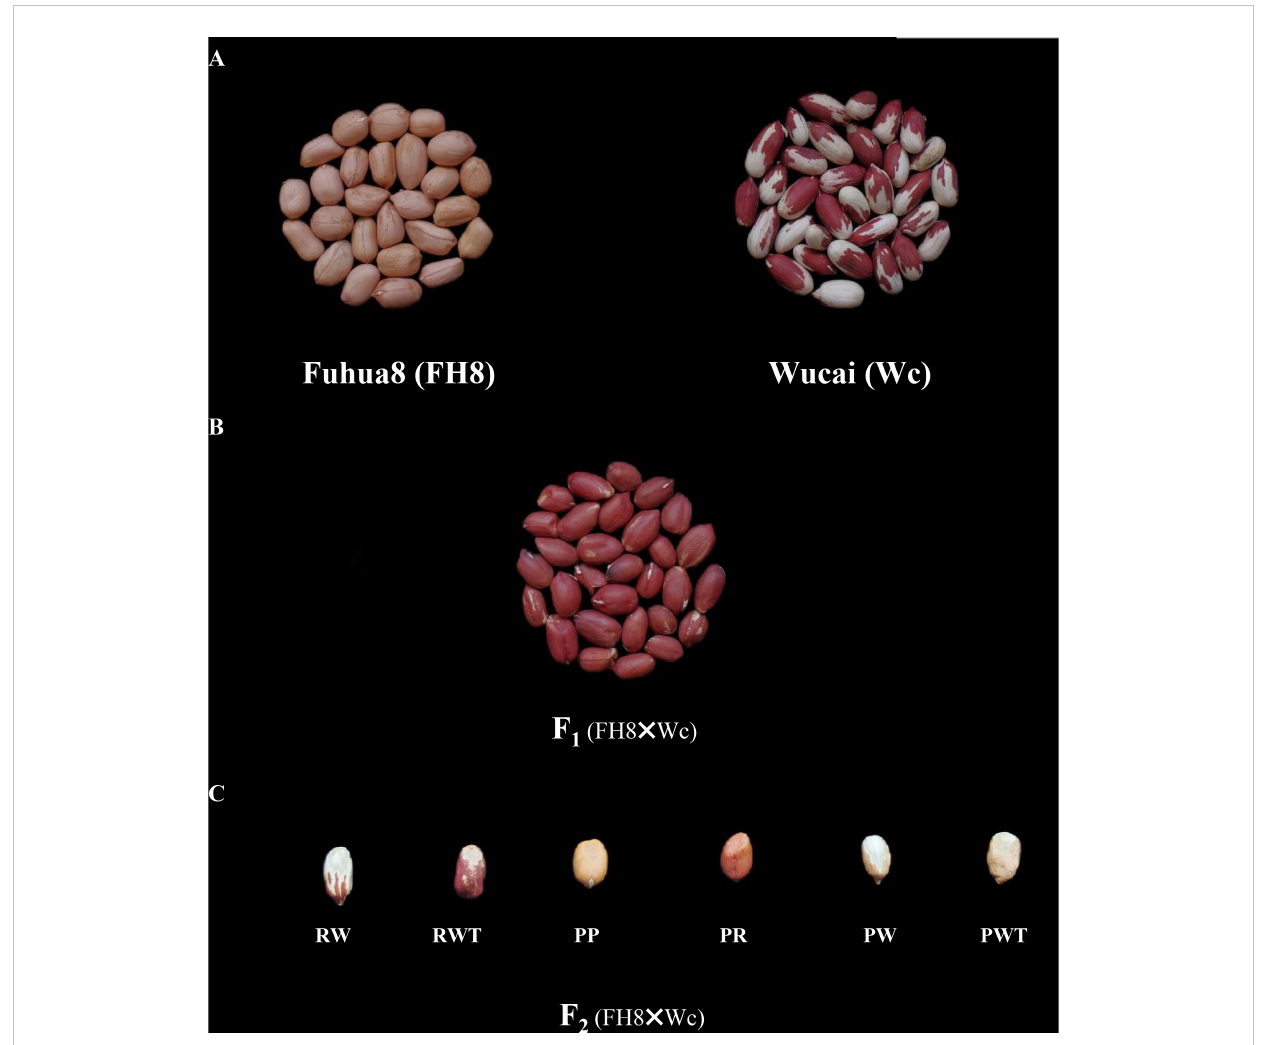
FIGURE 2 Comparison of testa color of peanut cultivar “ Fuhua 8 ” and “ Wucai ” , and the genetic analysis for variegated testa color in peanut. (A) . Seeds of pink testa cultivar “ Fuhua 8 ” and red on white variegated testa color landrace “ Wucai ” . Scale bar = 5 cm. (B) . The red on white trace testa seeds harvested from F 1 plants derived from the cross between “ Fuhua 8 ” and “ Wucai ” . (C) . The segregation of testa pigmentation pattern of seeds harvested from F 2 individuals derived from the cross between “ Fuhua 8 ” and “ Wucai ” . Pure red (PR), pure pink (PP), red on white variegated (RW), pink on white variegated (PW), red with white trace (RWT), and pink with white trace